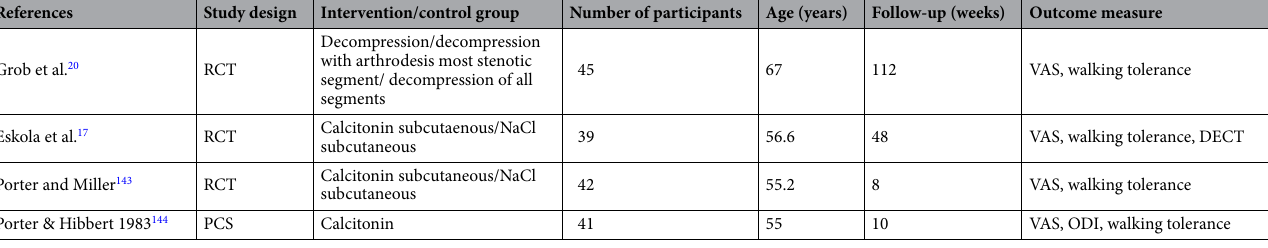
Table 2. Characteristics of the included studies. RCT randomized controlled study; PCS prospective cohort study; RCS retrospective cohort study; CCS case control study; CS case series; RaCS randomized cohort study; NR not reported; BSS Beaujon scoring system; DECT Digitest ergojump contact test; FFD Finger floor distance; JOA Japanese orthopedic association back pain evaluation questionnaire; LBOS Low back outcome score; MGPQ McGill pain questionnaire; NASS North American spine society instrument; NCOS Neurgenic claudication outcome score; NRS Numeric rating scale; ODI Oswestry disability index; PDI Pain analogue scale; ZCQ Zurich claudication questionnaire.